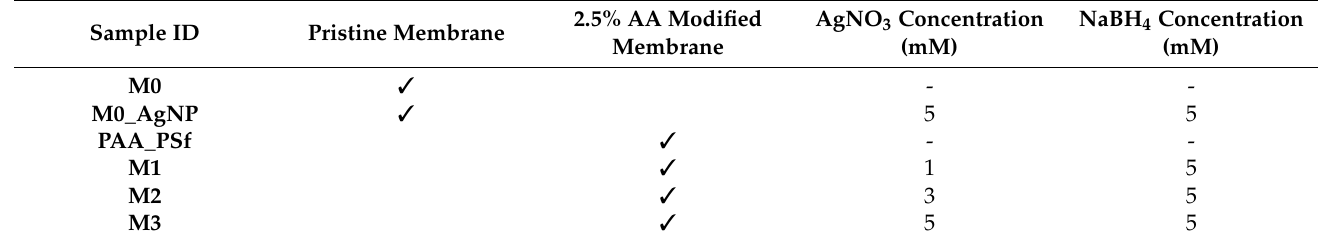
Table 1. Experimental conditions for the membrane